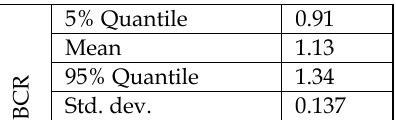
Table 2. Aggregated single point limits from the